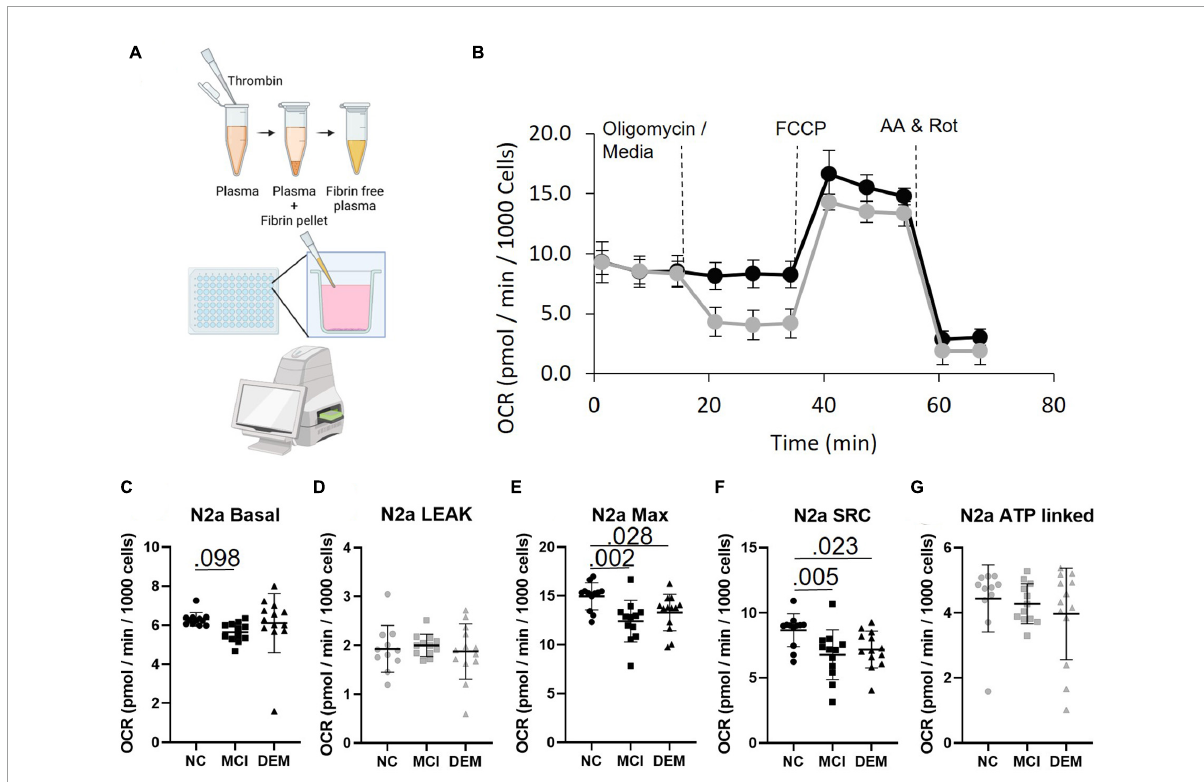
FIGURE2 Bioenergetics of N2a cells treated with fibrinogen-depleted plasma from NC, MCI, and DEM participants. (A) Schematic of bioenergetic workflow. (B) Representative Seahorse XF96 e trace. The gray line includes an oligomycin injection and the black line excludes the oligomycin injection. Measures of Leak and ATP-linked (plots have gray markers) are calculated from the assay with oligomycin. Measures of Basal, Max, and SRC (plots have back markers) are calculated from the assay without oligomycin, as oligomycin had an inhibitory effect on Max Respiration. (C–G) Basal, Leak, Max, SRC, and ATP-linked respiration by cognitive status. Exact P- values